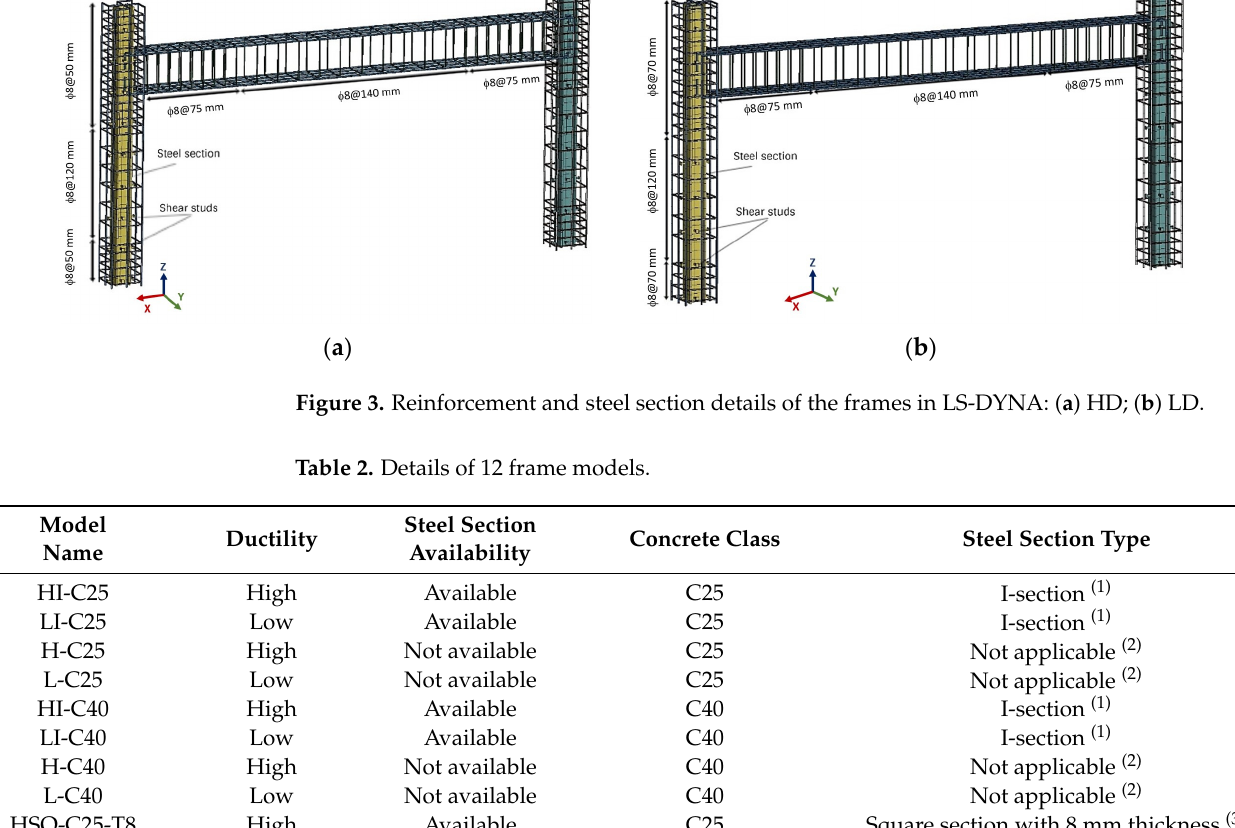
Figure 2. Reinforcement and steel section details of the tested frames: ( a ) HD; ( b ) LD; ( c ) cross-sec- tions [24]. Table 1. Reinforcement details of tested specimens [24].